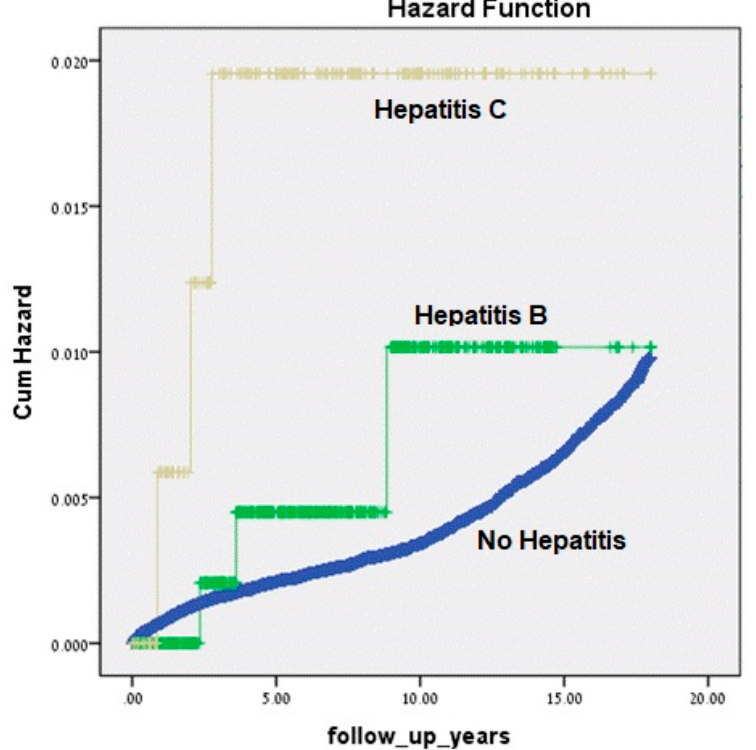
Figure 1. Kaplan–Meier survival curve demonstrating the cumulative incidence of hospitalizations involving endocrine morbidity in children born to mothers carrying chronic hepatitis C, B or no hepatitis during the pregnancy.